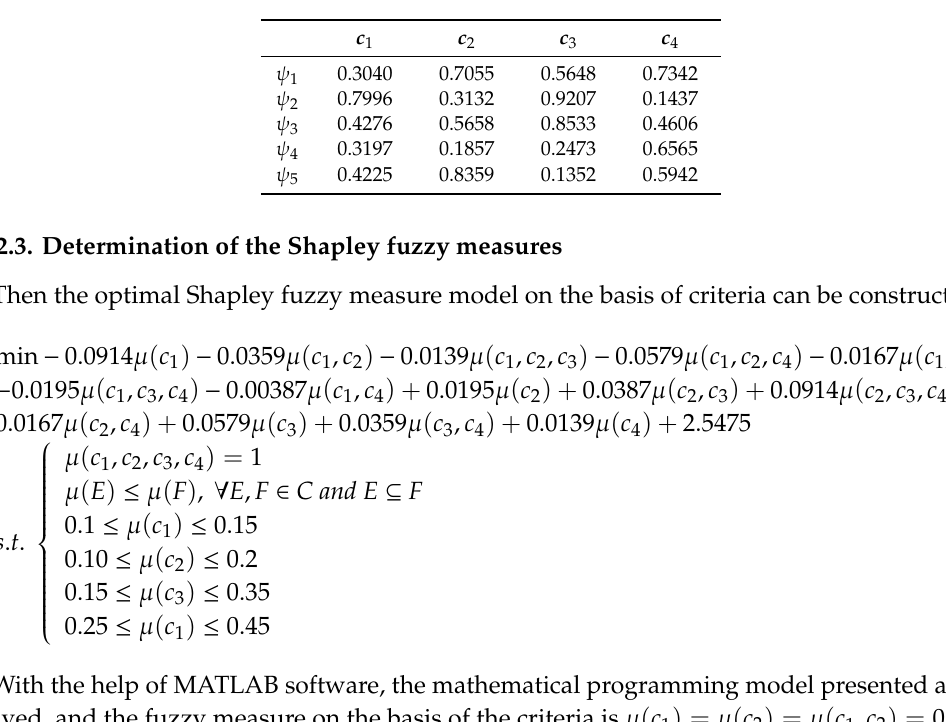
Table 3. Closeness coe ffi